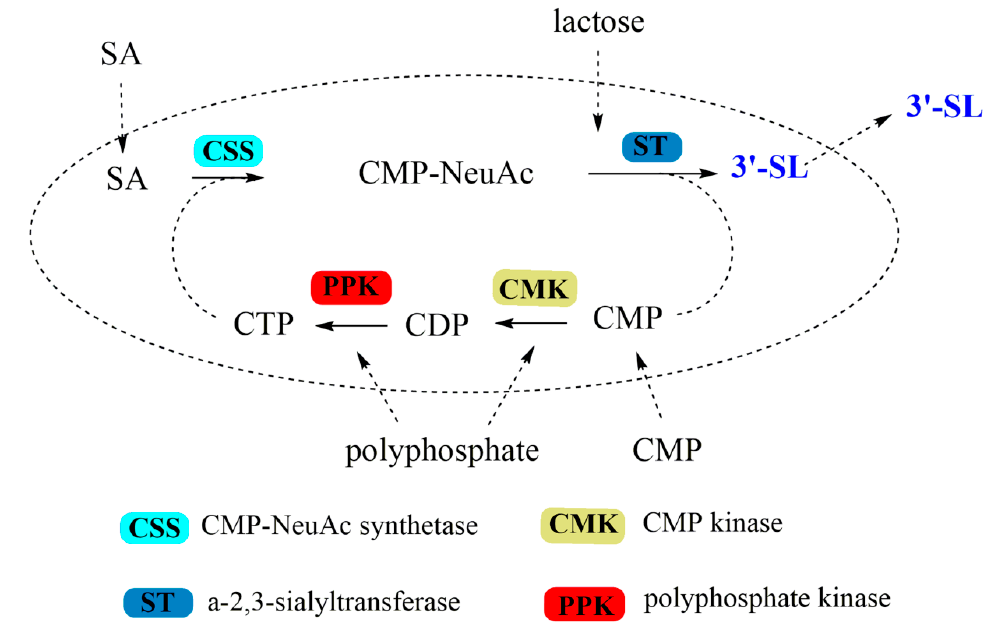
Figure 1. Diagram of single whole-cell multi-enzyme catalytic pathway.